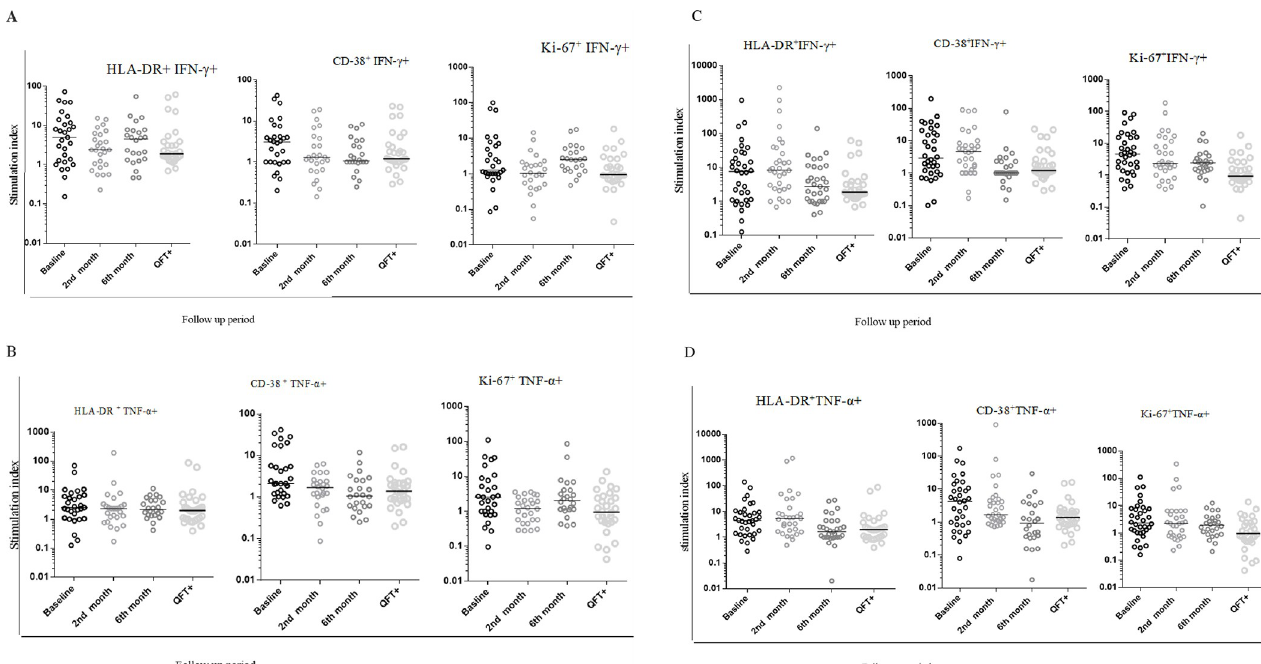
Fig 5. Level of expression of activation and proliferation markers from PPD specific IFN- γ + CD4 + T cells and TNF- α + CD4 + T cells in clinically resolved (6 month‘s time point after therapy initiation) PTB patients and QFT positive healthy controls. Refer to Fig 4 for further details. A:—the level of activation and proliferation markers expression from IFN- γ + CD4 + T cells between smear negative PTB patients and QFT positive apparently healthy study participants. B: —the level of activation and proliferation markers expression from TNF- α + CD4 + T cells between smear negative PTB patients and QFT positive apparently healthy study participants. C:—the level of activation and proliferation markers expression from IFN- γ + CD4 + T cells between smear positive PTB patients and QFT positive apparently healthy study participants. D:—the level of activation and proliferation markers expression from TNF- α + CD4 + T cells between smear positive PTB patients and QFT positive apparently healthy study participants. Stimulated indices were calculated as the frequency of marker positive/cytokine positive cells cultured in the presence of PPD divided by that in the absence of PPD. The bars within each plot indicate the median value for each marker and time point. Data analysis was done using non-parametric Wilcoxon matched-paired rank test with significant p values indicated. Baseline represents values prior to initiation of standard anti-TB drugs. 2 nd and 6 th month refers to time after therapy initiation. QFT + - Quantiferon TB gold assay positive for apparently healthy study